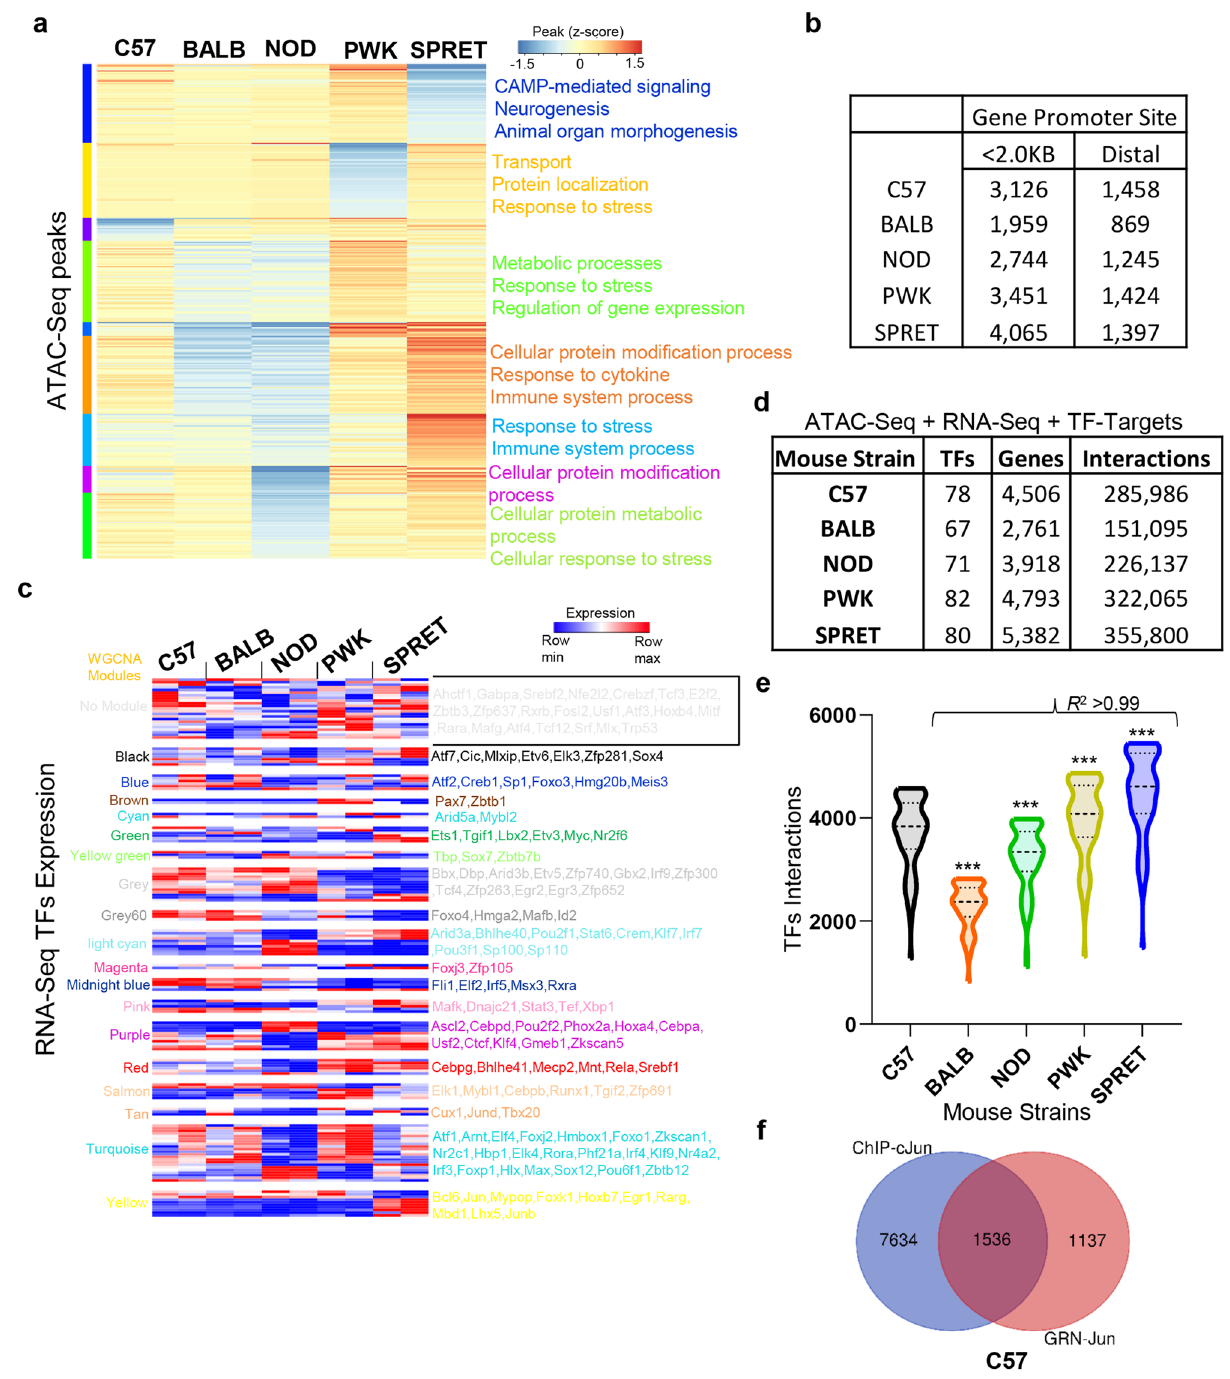
Figure 4. Differential chromatin accessibility and Transcription factors (TFs) interaction in unstimulated macrophage to maintain basal homeostasis in diverse murine strains. ( a ) Heatmap of accessible chromatin peak genes clustered by k-mean clustering and annotated with enriched biological processes in five mice strains. ( b ) Distribution of peaks in the promoter and distal region in five murine strains. ( c ) Heatmap of 124 Transcription Factors (TFs) was expressed across five strains of mice in RNA-seq (TPM > 1). The TFs are grouped according to their WGCNA assigned modules. The clustered columns represent the expression in mice strains, whereas each row represents a TF. Data is row-mean normalized and row clustered using correlation distance and average linkage. ( d ) Gene regulatory network (GRN) components of expressed TFs, expressed and chromatin accessible genes (TPM > 10) in C57,BALB, NOD, PWK, and SPRET murine strains. ( e ) Network analysis of individual GRNs revealed differential interactions for the same TF in all five mice strains at unstimulated macrophage (correlation ( r 2 = 0.99) and P < 0.0001 when compared to C57 strain). ( f ) ChIP-Seq of cJun and interactions of Jun in GRN of C57 murine model identified more than 57% of target genes